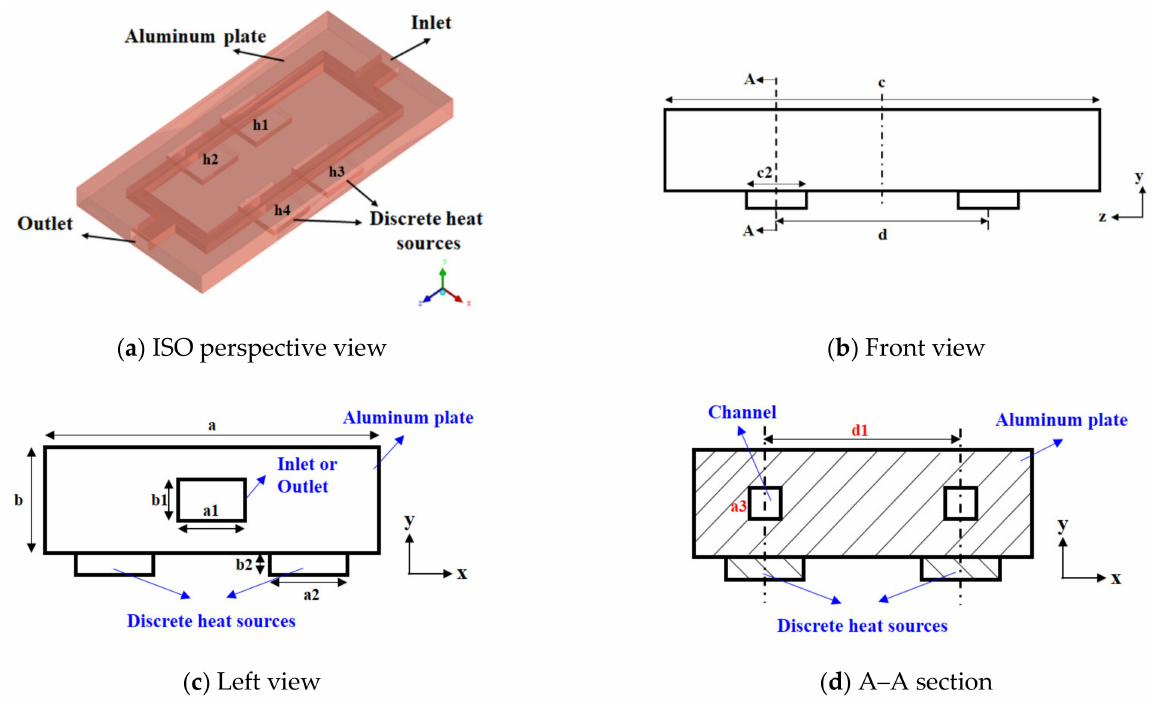
Figure 1. Schematic of geometry. Table 1. Geometric